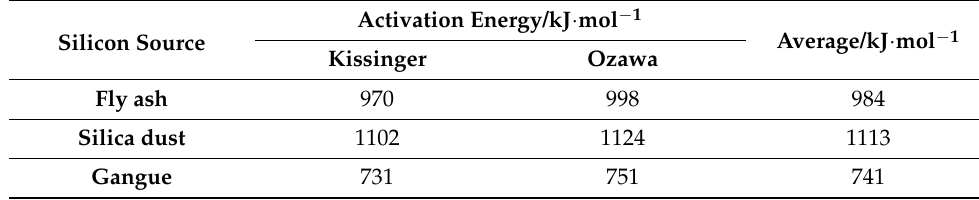
Figure 7. Differential thermal analysis of specimens from different silicon sources: ( a ) Fly ash; ( b ) Silica dust; ( c ) Gangue. According to the analysis results in Figure 7, the phase transition kinetics fitting results of AD mixed with the three silicon sources based on Kissinger (Equation (5)) and Ozawa (Equation (6)) method are shown in Figures 8 and 9, respectively. It can be seen from the figures that the correlation coefficients R 2 of the three samples based on different